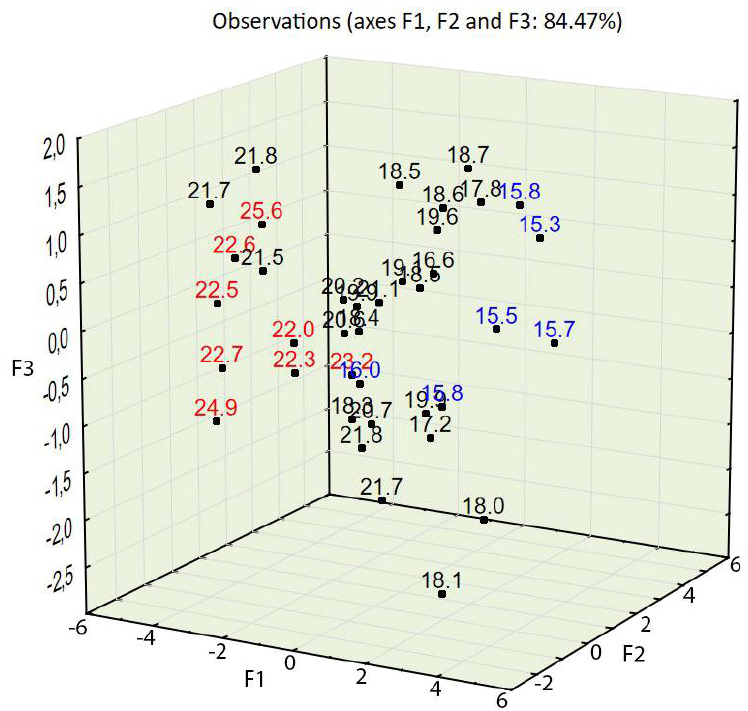
Figure 9. PCA with object grouping in a three-dimensional space on the basis of concrete composition in relation to concrete properties. Compressive strength: red represents a strength of 22 MPa or above, and blue represents a strength of 16 MPa or below.